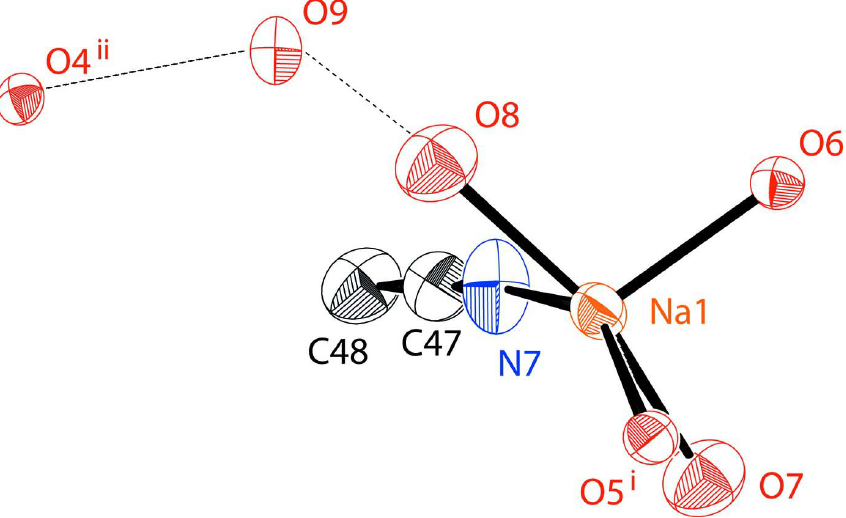
Figure 3 shows two distinct intermolecular O···O interactions, dashed lines, that link two azo-Fe complex dimers: O8···O9 and O9···O4 ii Hydrogen atoms on O8 and O9 could not be located in difference electron density maps [symmetry codes (i): - x + 1, - y , - z + 1 and (ii): x , -1 + y , z